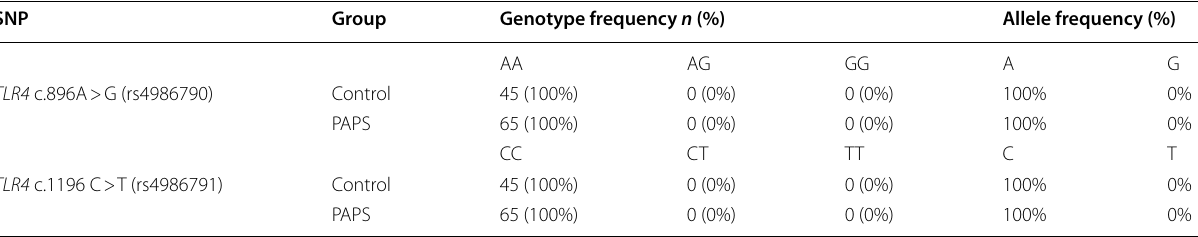
Table 3 Genotypes and allele frequencies of SNPs among patients with PAPS and control